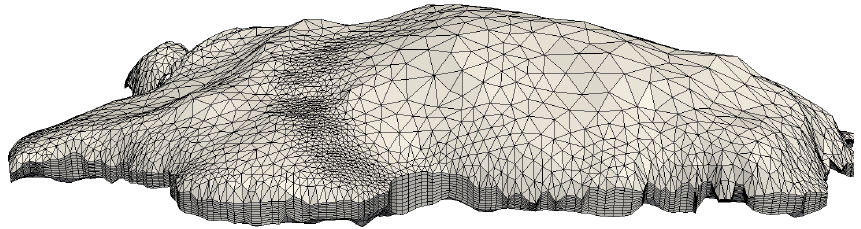
Fig. 4. 3D view of ASF showing the mesh refinement over the B3 outlet glacier, just left of centre. Vertical exaggeration is 30 times.